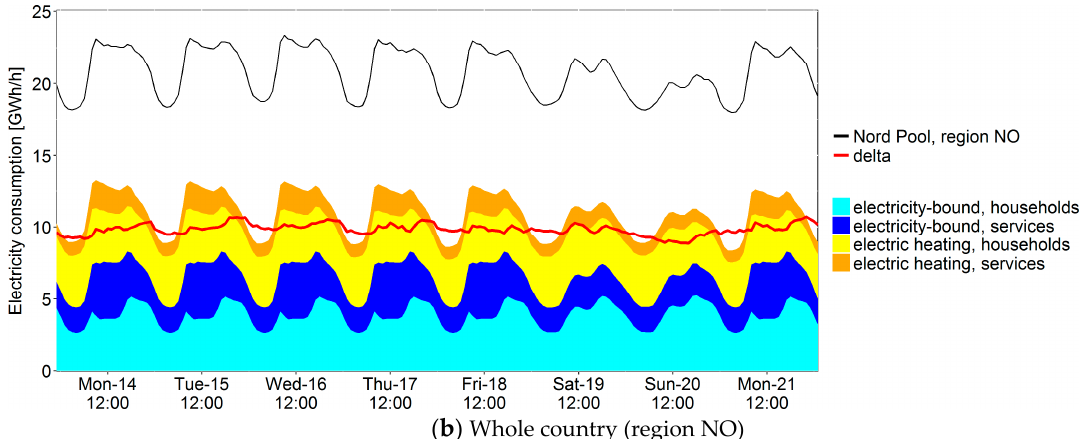
Figure 8. Modeled electricity consumption in household and service sector, metered total consumption [47], and residual consumption delta, January 2013.